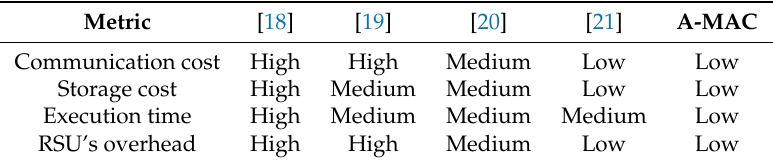
Table 3. Summary of performance of various schemes under comparison.